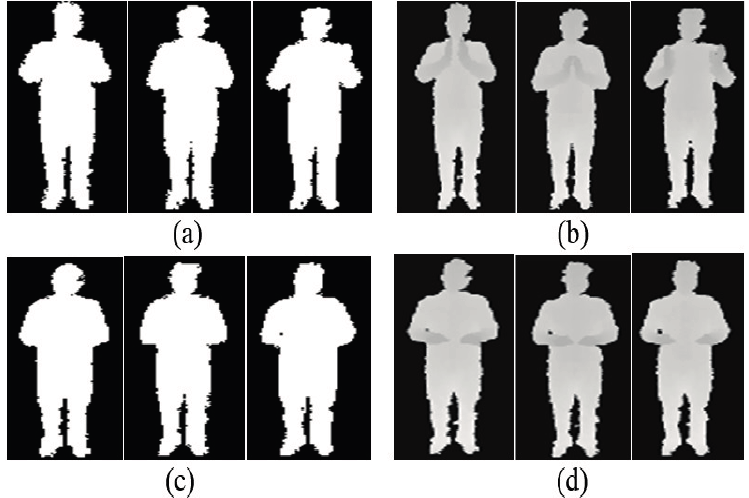
Figure 2. Some examples of image sequence of binary and depth